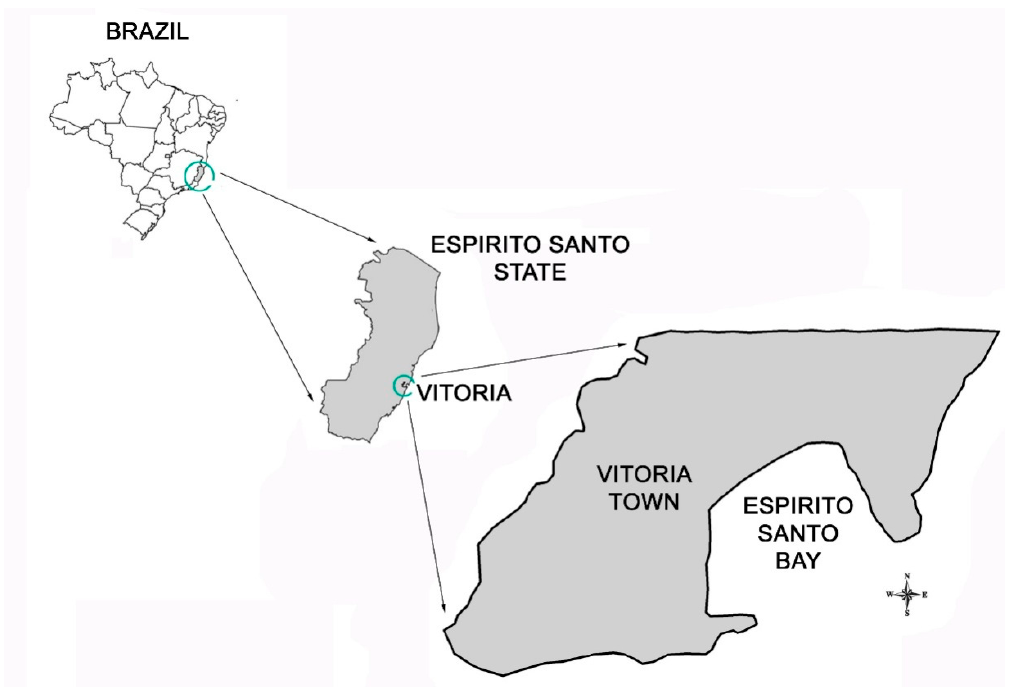
Figure 1. Esp í rito Santo Bay. Figure 1. Espírito Santo Bay.